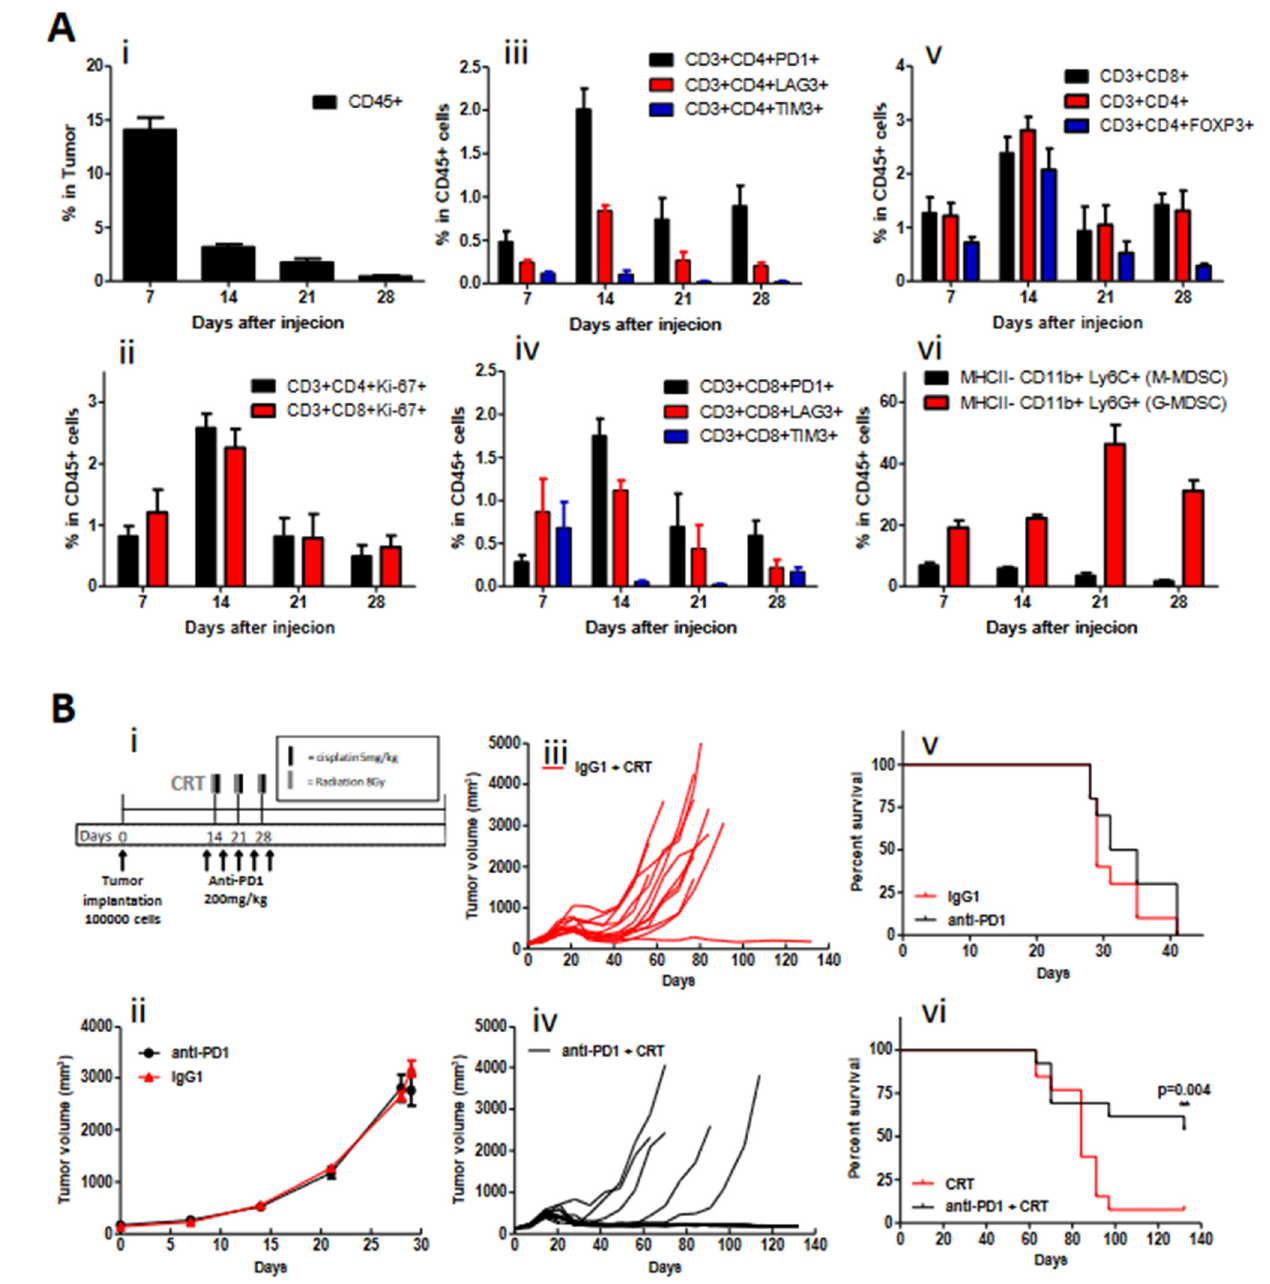
Figure 1. PD-1 Blockade during chemoradiotherapy enhances tumor clearance and survival in the mEERL model. ( A ) time course of changes in the relative number (expressed as percentage of CD45+ immune cells) ( i ) of CD3+ CD4+ and CD3+ CD8+ T cells (proliferative Ki67 cells ( ii )) with PD-1, TIM-3, LAG-3 expression ( iii , iv ), Treg (FoxP3+) cells ( v ), and suppressor (M-MDSC and G-MDSC) immunocytes after mEERL tumor implantation ( vi ). ( B ) Experimental treatment schema ( i ), Average tumor volume and survival ratio after treatment alone with IgG1 isotype control and PD-1 inhibitor ( ii ) and individual growth curves in combination with chemoradiotherapy (CRT) ( iii , iv ) in mEERL murine model. Survival ratio with anti-PD-1 monotherapy versus IgG1 isotype control ( v ) and combination CRT + IgG1 isotype control versus and anti-PD1 + CRT ( vi ) ** ( p ≤ 0.004). For chemoradiation experiments, after palpable tumors developed (day 12), mice ( n = 15/group) were anesthetized with 87.5 mg/Kg ketamine and 12.5 mg/Kg